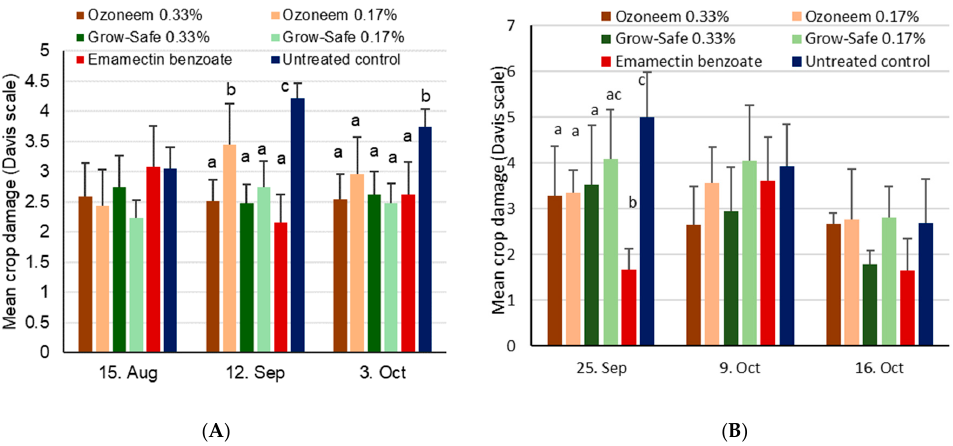
Figure 5. Mean crop damage induced by FAW + SD found in the neem trial during vegetative growing stages conducted in 2018. Within a given date, bars sharing the same letters are not significantly di ff erent from each other. If no letters are shown, this indicates that no di ff erences were found. ( A ) Site 1 near Wa, Upper West, Ghana, where treatments were applied on 16 August, 6 September, and 27 September. ( B ) Site 2 near Accra, Ghana, where treatments were applied on 20 September and 10